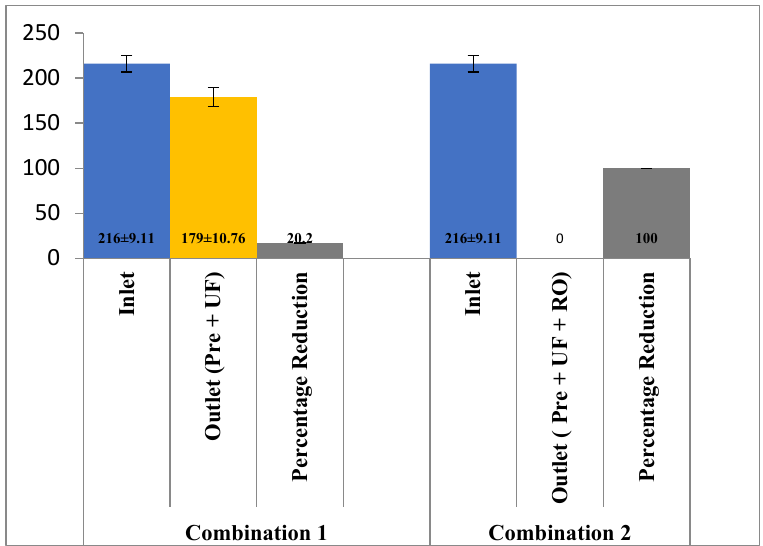
Figure 6. Effect of different treatment setups on the COD rejection.